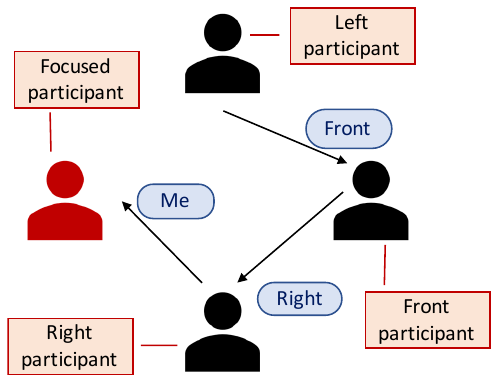
Figure 2. Conceptual diagram of the transformation of attention